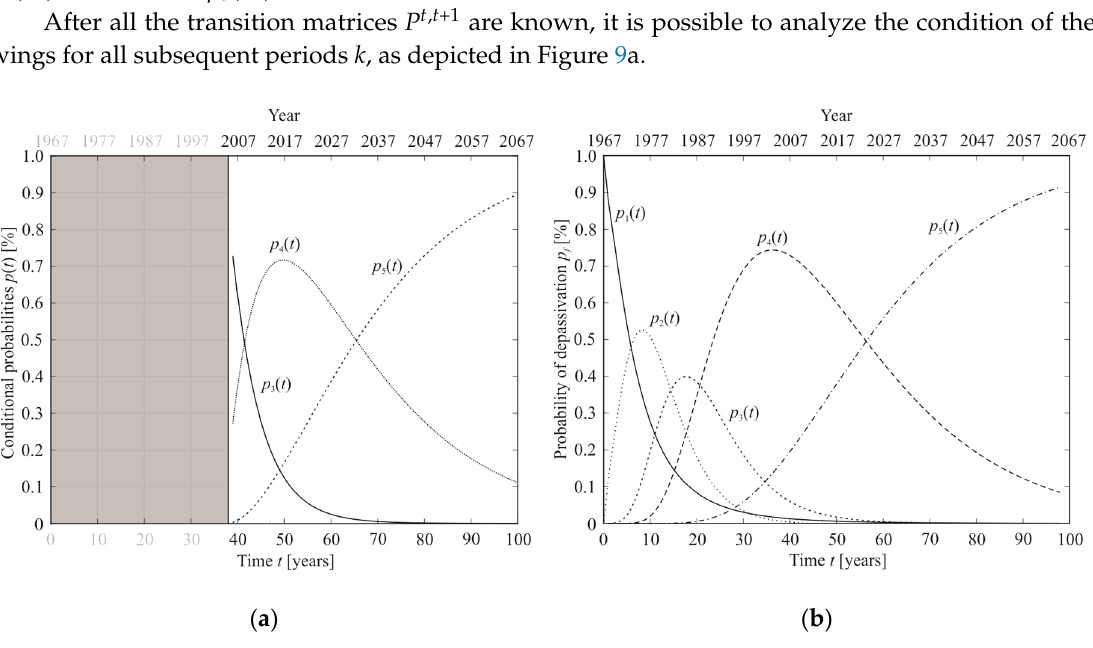
Figure 9. Probability that the process will assume one of the condition states i for subsequent periods k , ( a ) assuming wings were in CS3 in 2005 at the age t = 38 years; ( b ) assuming wings were in CS1 at the age t = 0